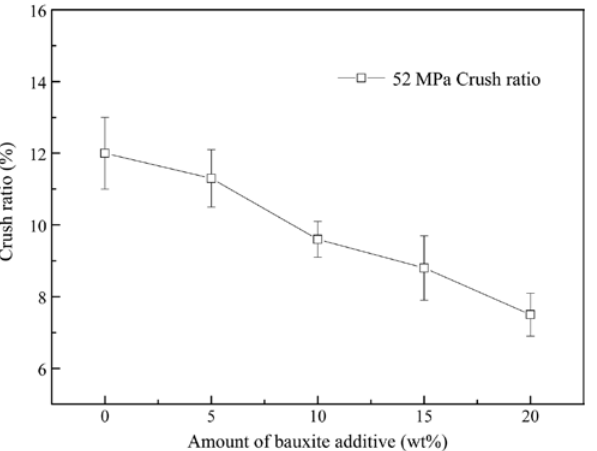
Figure 2: The crush ratio under 52 MPa pressure of the proppants sintered at 1200 ° C with different amounts of the bauxite additive.